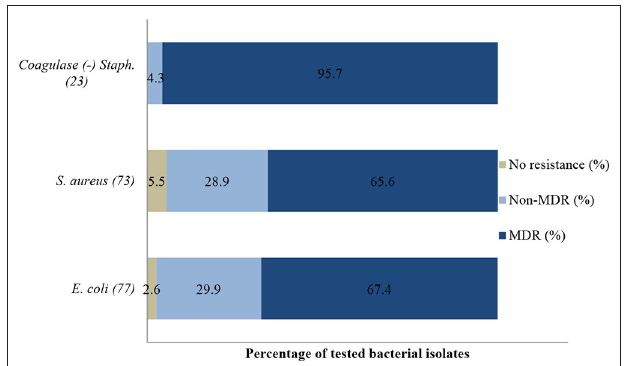
FIGURE 5 | Multi-drug resistance of clinically important bacterial pathogens from diseased ruminants between 2015 and 2017. Numbers inside brackets “()” indicate number of isolates detected; those on bars indicate percentage per organism; Non-MDR–Only resistant to 1 or 2 classes; MDR–multi-drug